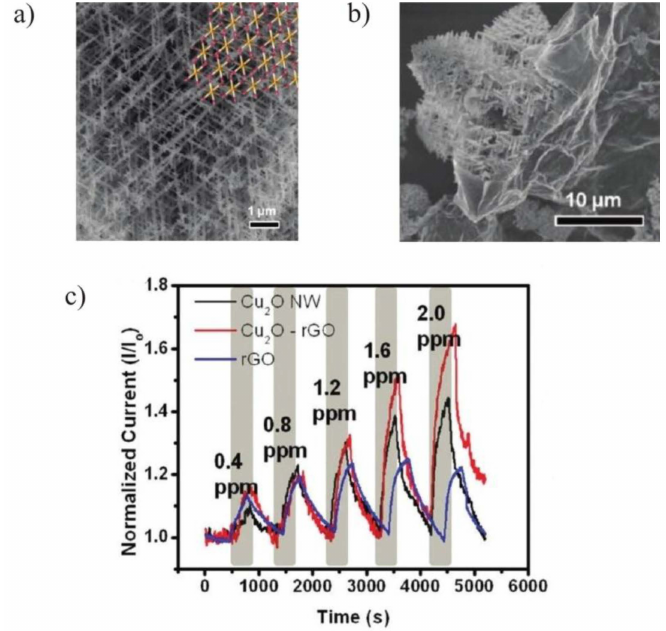
Figure 3. ( a ) FESEM image of Cu 2 O mesocrystal with octahedron morphologies comprised of branched nanowires; ( b ) FESEM image of Cu 2 O-rGO mesocrystal; ( c ) The response of rGO, Cu 2 O NW, and Cu 2 O-rGO sensor devices under increasing NO 2 exposure. {Reprinted with permission from [55], © 2012 American Chemical